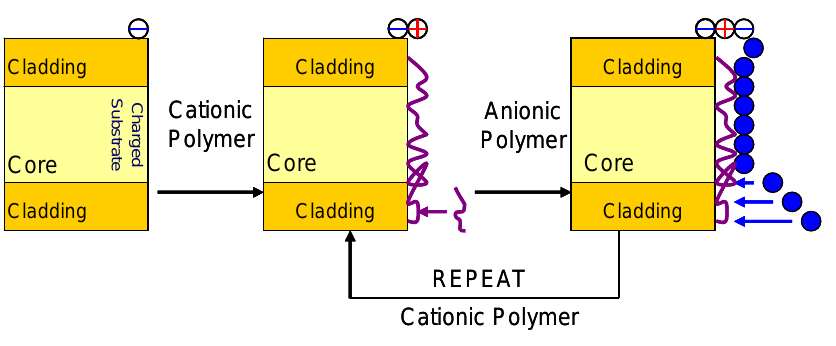
Figure 16. ESA method schematic construction